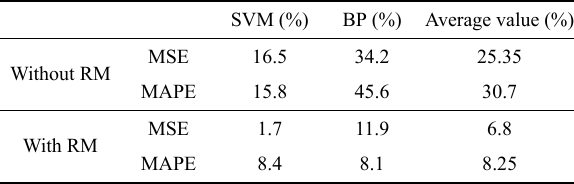
Fig. 8 Goodness of fit (input variables are T , P , BCl 3 , CH 4 , BHCl 2 , BHCl 3 , BCl 2 , HCl, and H 2 ). Table 5 Mean absolute percentage error and mean square error of predicted results